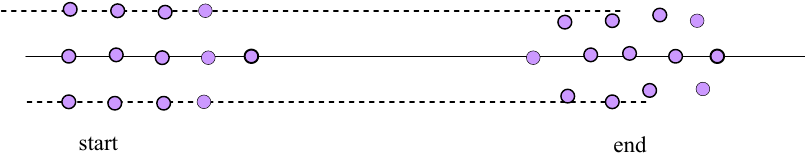
Figure 17. The robot structure for a nonhierarchical swarm.